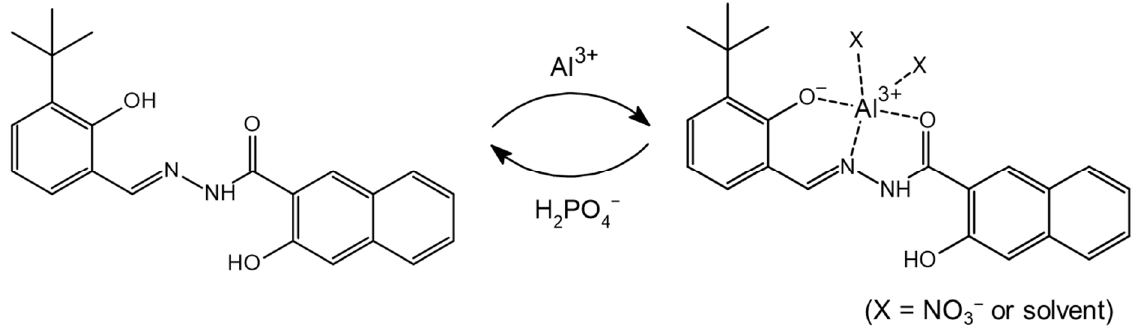
Scheme 2. Sequential recognition mechanism of Al 3+ and H 2 PO 4 − by NATB .